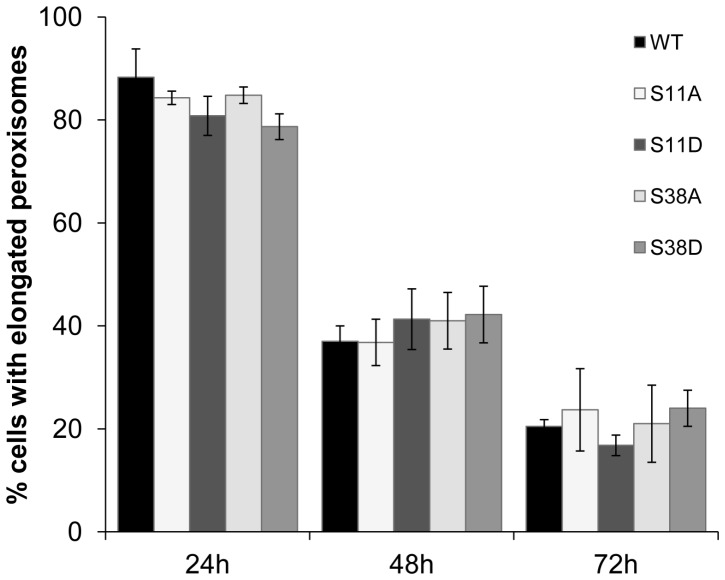
Phospho-mimicking mutants of Pex11pβ do not influence peroxisomal elongation and division.COS-7 cells expressing Pex11pβ-Myc, Pex11pβ-MycS11A, Pex11pβ-MycS11D, Pex11pβ-MycS38A and Pex11pβ-MycS38D were processed for immunofluorescence using anti-Myc and anti-Pex14p antibodies (Suppl. Fig. S4) and peroxisome morphology was quantified. Data are from 3 independent experiments and are presented as means ± S.D.